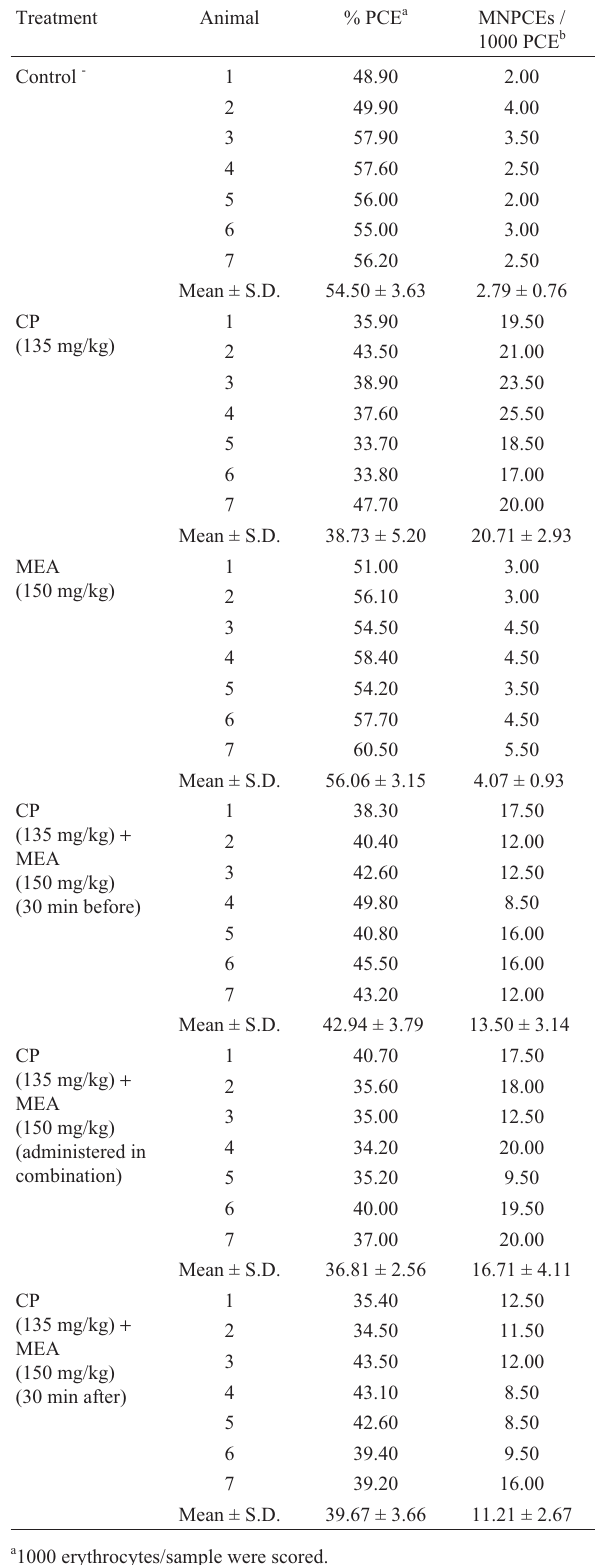
Table 2 - The effect of mea on the frequencies of MNPCEs in bone marrow of mice after treatment with CP. Treatment Animal